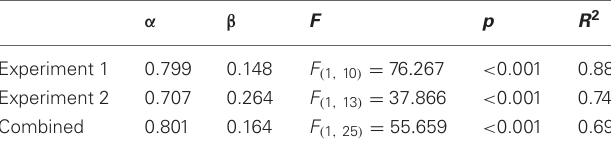
Table A6 | Results of the regression